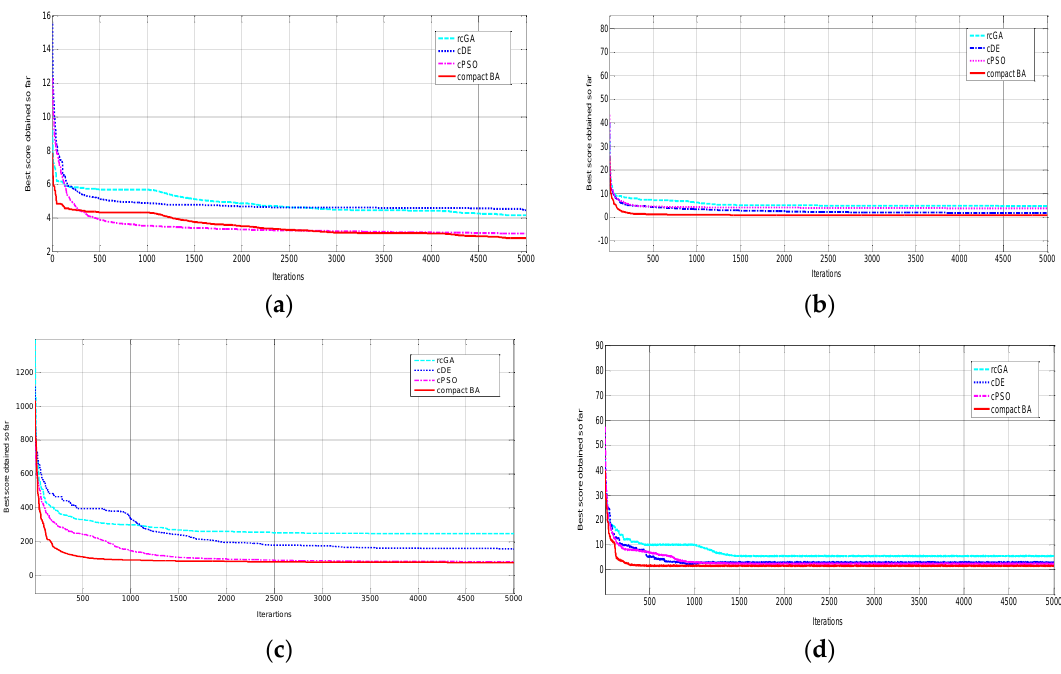
Figure 4. Comparison of four compact algorithms of rcGA, cDE, cPSO, and cBA for the selected testing functions: ( a ) is f1, ( b ) is f2, ( c ) is f5 and ( d ) is f7.